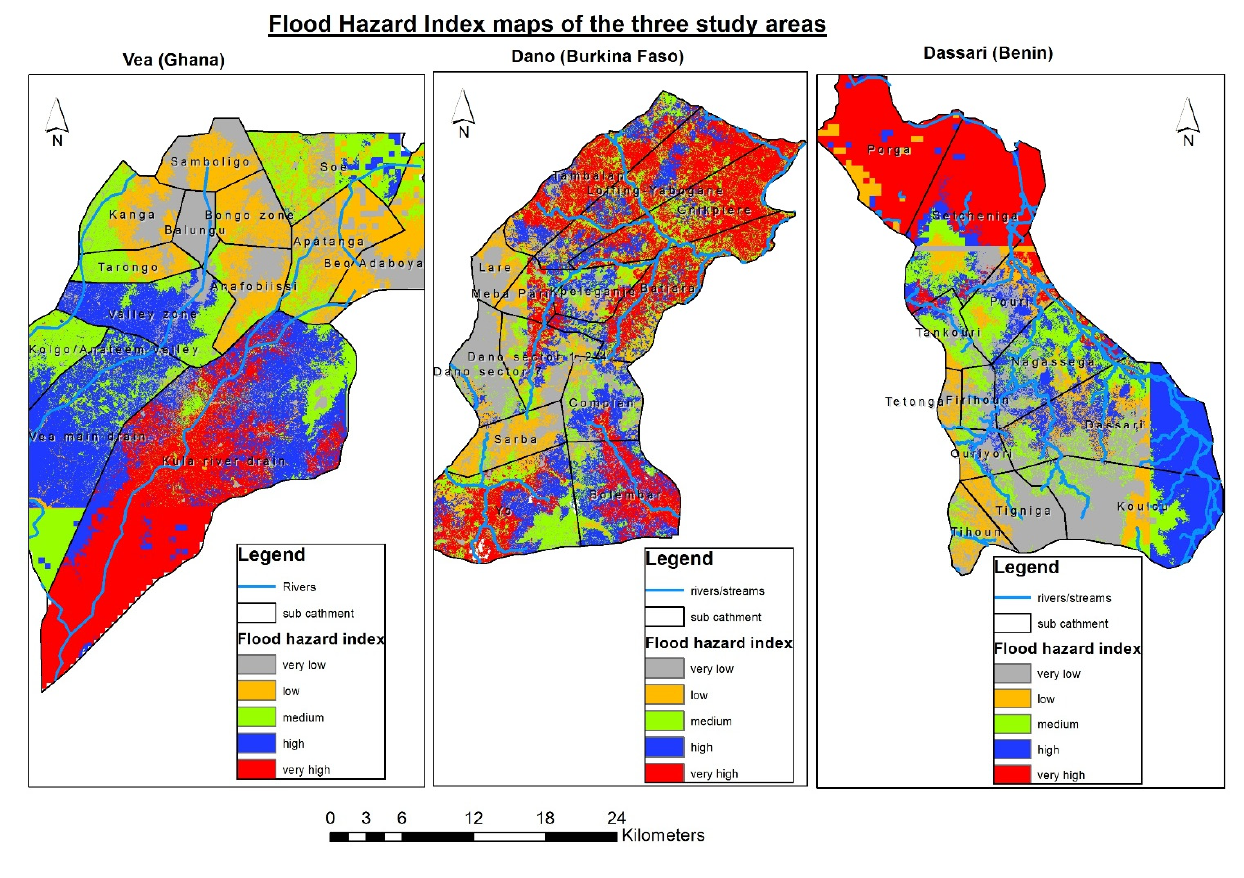
Figure 8. Flood hazard